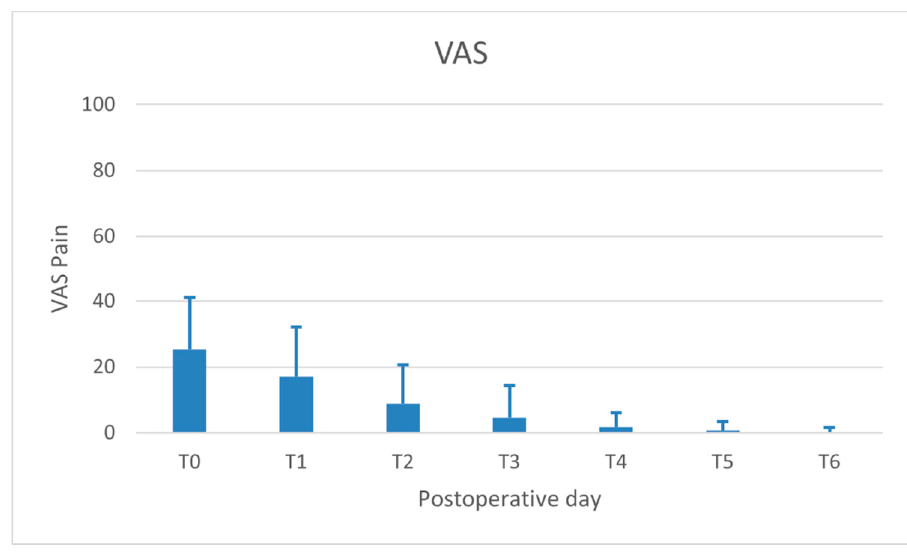
Figure 5. Trend of subjective pain assessed by visual analogue scale (VAS) on the day of surgery (T0) and the following six postoperative days.